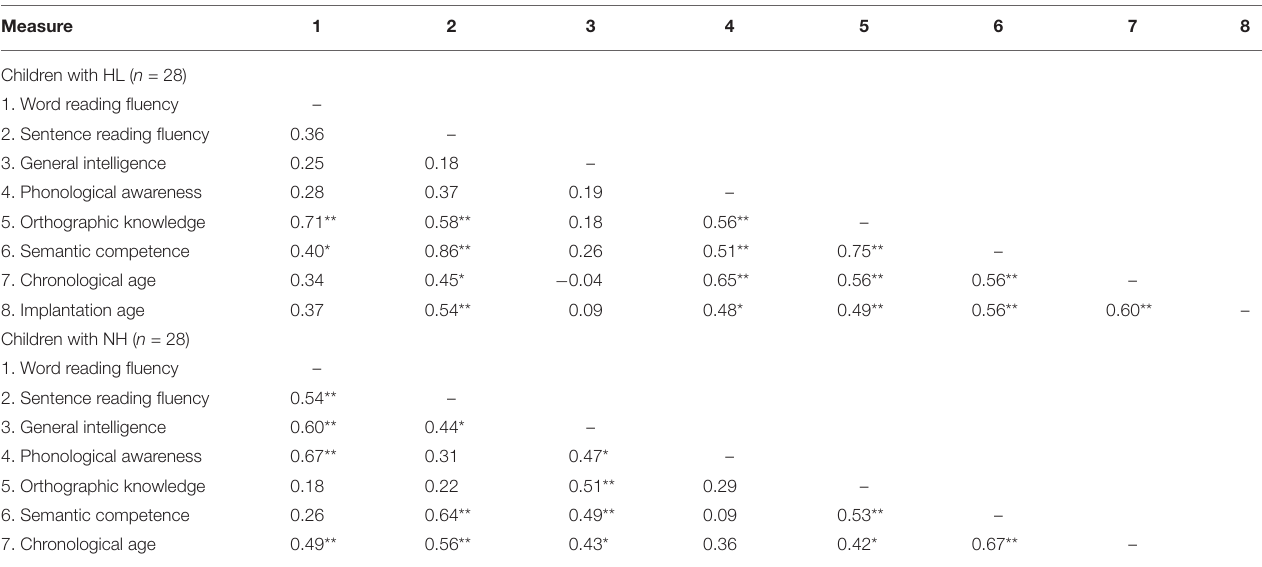
TABLE 2 | Bivariate correlations among age, general intelligence, predictors, word reading fluency and sentence reading fluency separately children with HL and NL.